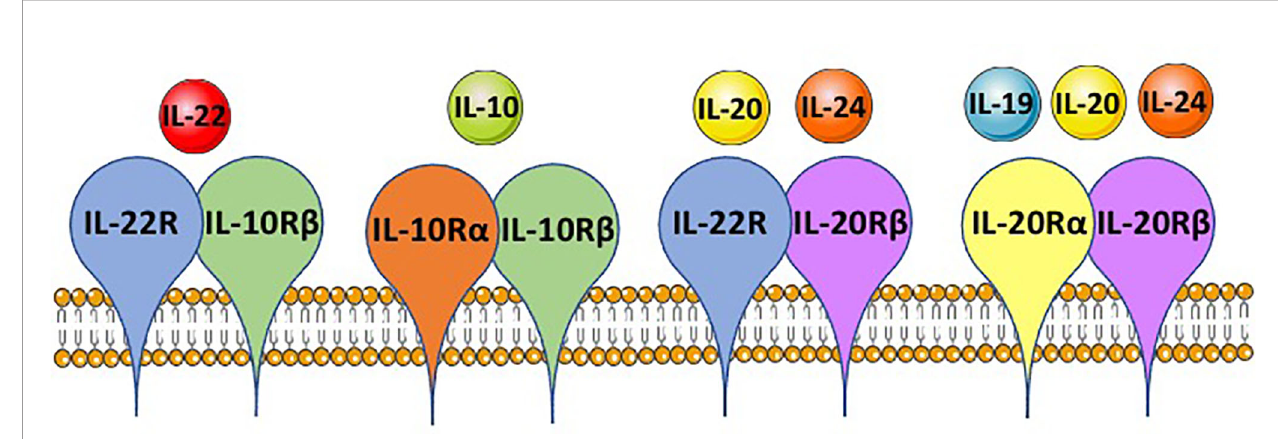
FIGURE 2 | IL-10 family member shared receptor usage. IL-10 family members, IL-10, IL-19, IL-20, IL-22 and IL-24, each bind to a heterodimeric receptor and receptor chains are shared between the cytokines. IL-22 binds to the IL-22R-IL-10R b complex, IL-10 binds the IL-10R a -IL-10R b complex, IL-20 and IL-24 both can bind the IL-22R-IL-20R b complex, and IL-19, IL-20 and IL-24 can bind the IL-20R a -IL-20R b complex. This is based on mouse immunology. The fi gure was prepared by modifying Servier Medical Art, licensed under a Common Attribution 3.0 Generic License.